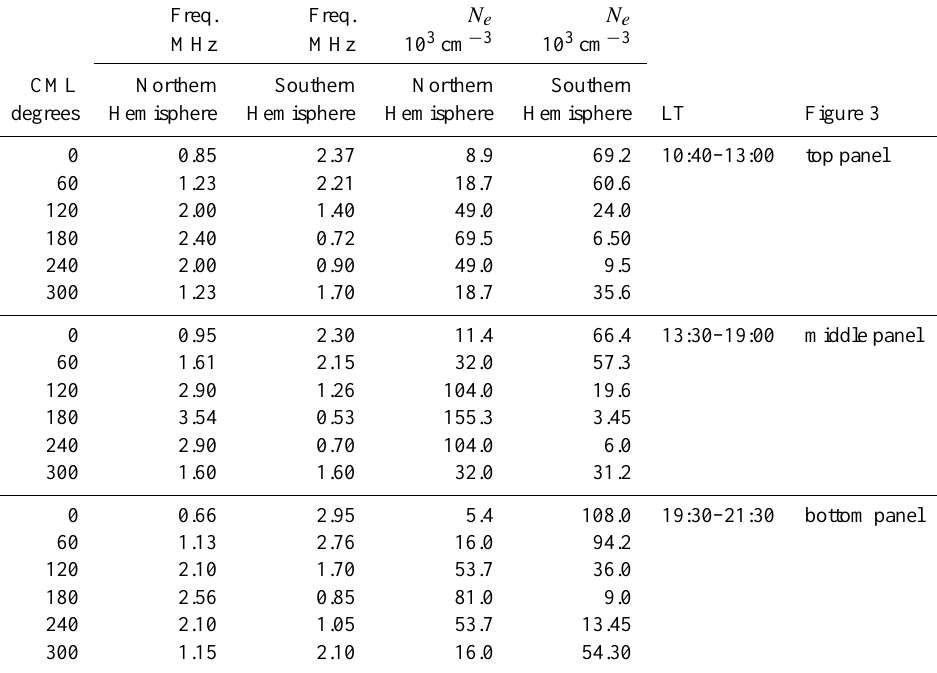
Table 1. Estimation of the electron density in the Io plasma torus during three local time intervals: 10:40–13:00LT (i.e., LT1), 13:30–19:00LT (i.e., LT2), and 19:30–21:30LT (i.e., LT3). For each hemisphere (north or south depending on the source location of the Jovian hectometric emissions) we give the variation of CML versus the attenuation band frequency, and the corresponding electron density in the Io plasma torus that is at the origin of the HOM